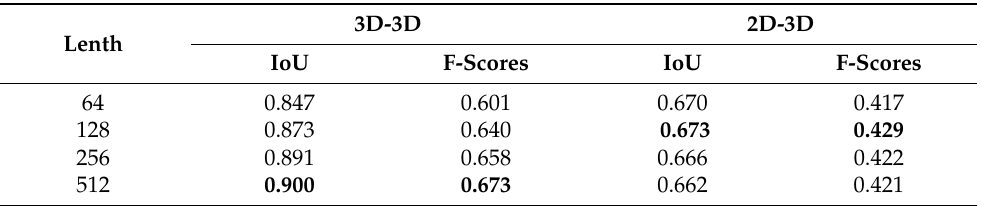
Table 2. Comparing IoU and F-scores of our method with different length of latent feature vector. We highlight the best scores in bold. 3D-3D 2D-3D Lenth IoU F-Scores